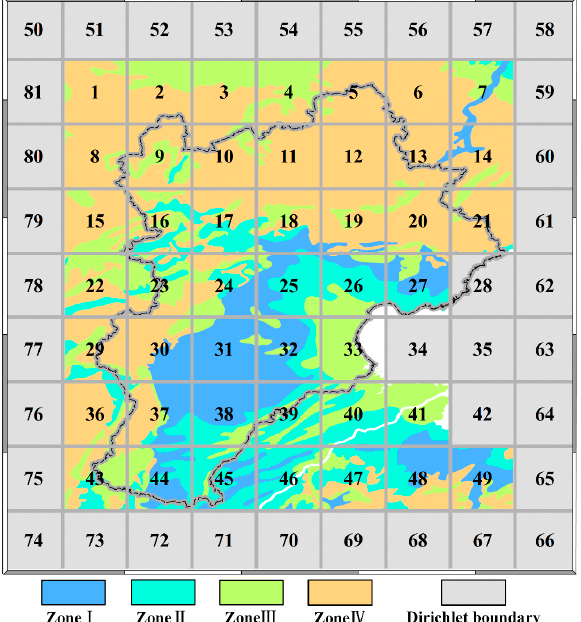
Figure 3. Parameter partitioning and boundary conditions of the study area. Zone I, Zone II, Zone III, and Zone IV represent the pore water of the alluvial–pluvial layer in the piedmont depositional plain, pore water of the alluvial–pluvial layer of the plain, pore water of the alluvial–pluvial layer of the intermountain basin or the coastal plain, and fissure water of the clastic rock in the mountains and hills or the hilly plain, respectively. The grey grid cells are the Dirichlet boundary.